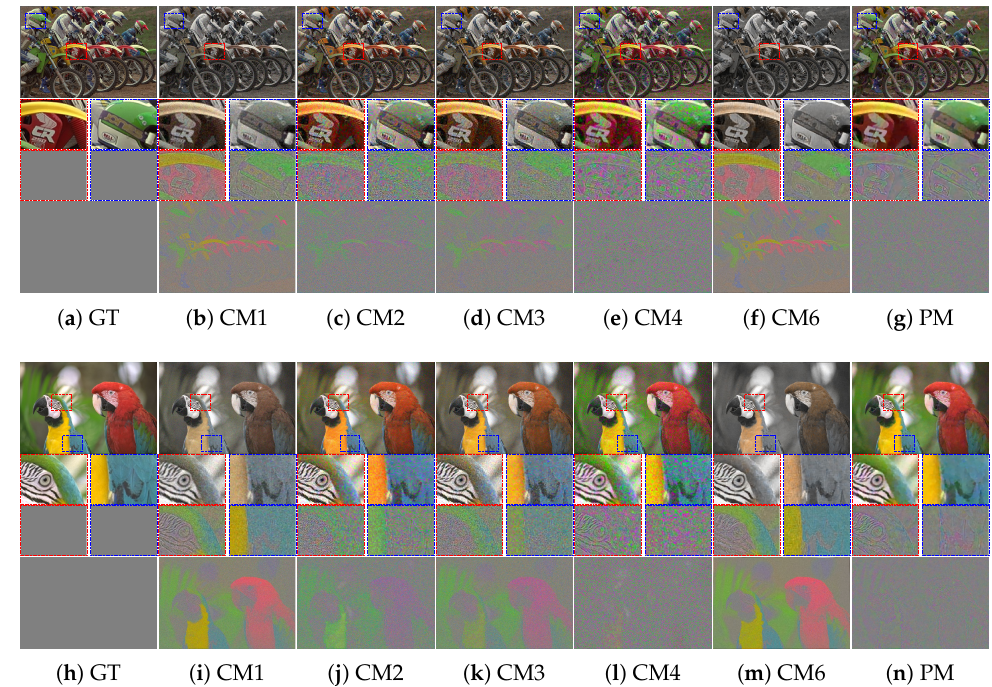
Figure 7. Visual comparison of restored images, enlarged parts, and difference maps from crosstalk degradation 2 (crosstalk kernel with σ g = 0.6 and noise with σ n = 0.04): ( a ) Ground truth, ( b ) CM1, ( c ) CM2, ( d ) CM3, ( e ) CM4, ( f ) CM6, and ( g ) PM. ( h – n ) Same methods as in ( a – g ). The first and second rows present the results of Bike and Parrot in the Kodak dataset,